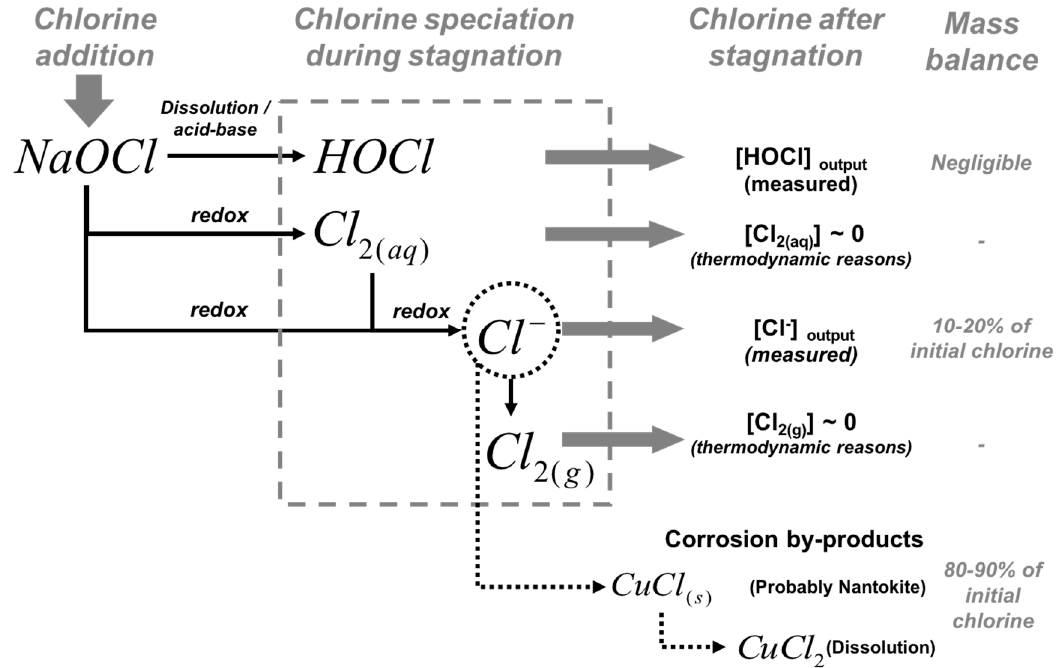
Figure 5. Speciation of free chlorine during stagnation. According to thermodynamic consideration and a mass balance of chlorine within the pipe during stagnation, most of the reduced chlorine precipitates as corrosion by-products, probably nantokite (CuCl).